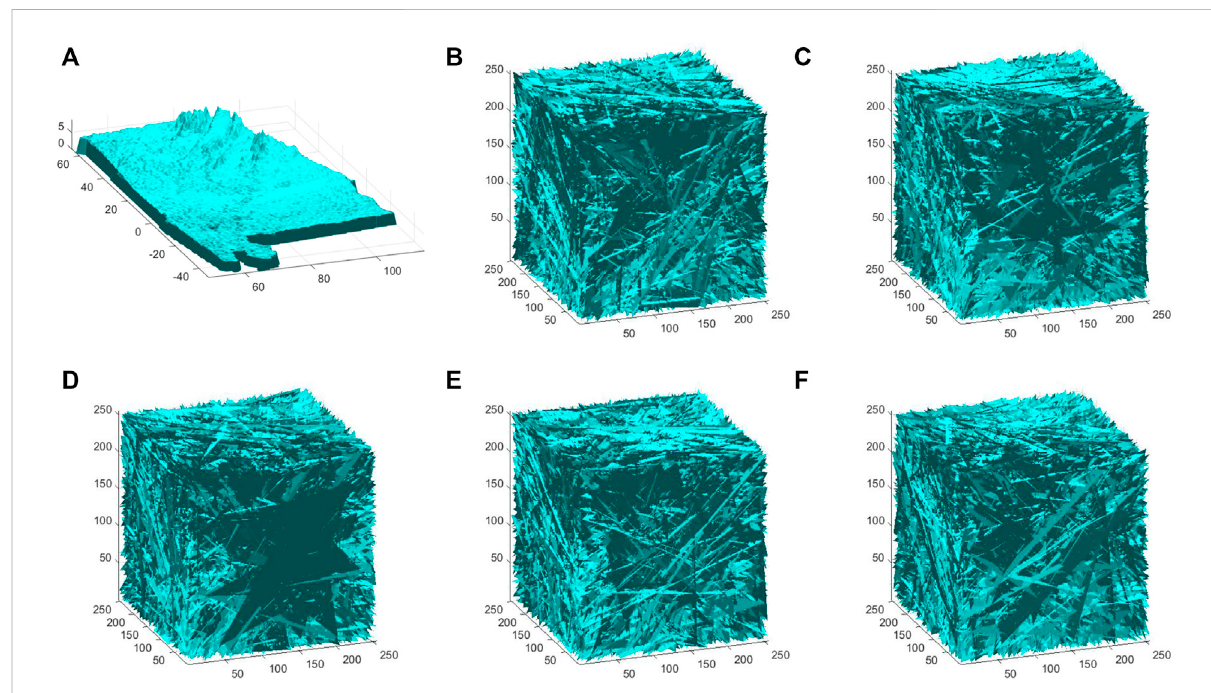
FIGURE 11 KeysensitivityanalysisofSMCLM-3ME. (A) Decryptedby ψ . (B) decryptedby ψ 1 . (C) Decryptedby ψ 2 . (D) Decryptedby ψ 3 . (E) Decryptedby ψ 4 . (F) Decrypted by ψ 5 .